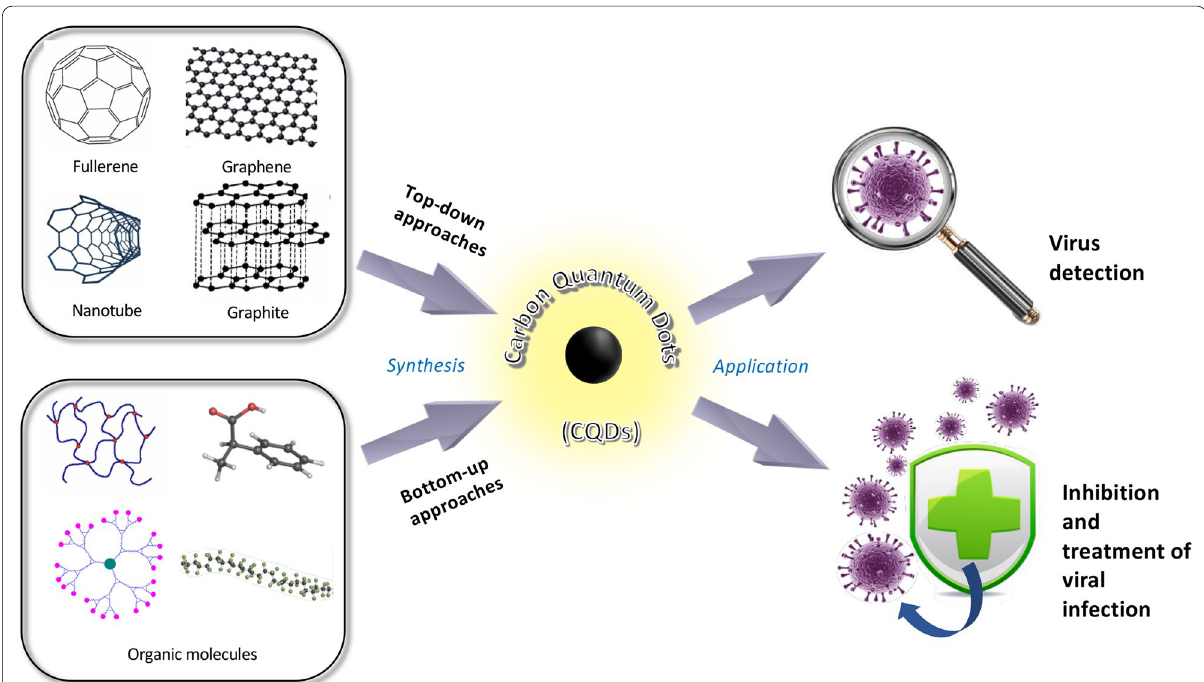
Fig. 1 Schematic representation of synthesizing carbon quantum dots for the detection, prevention/inhibition, and treatment of pathogenic